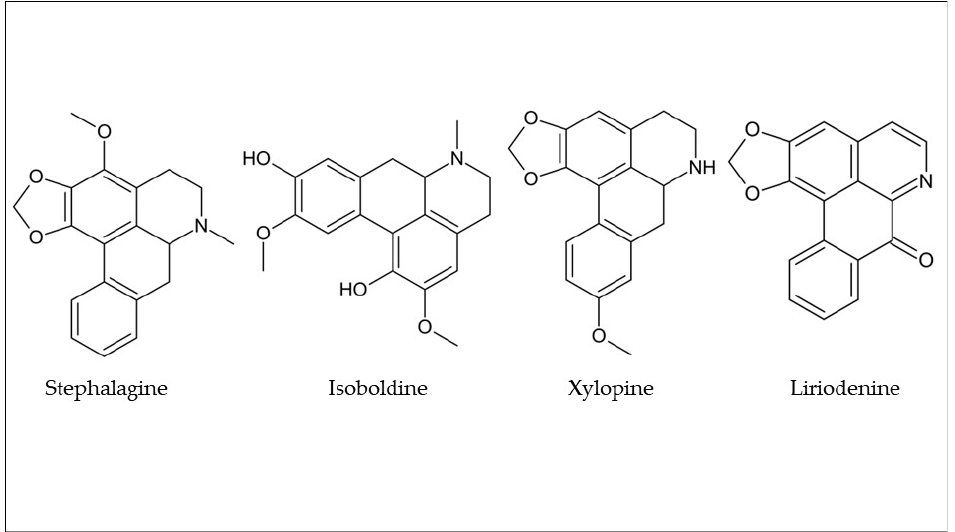
Figure 3. Chemical structures of the most common alkaloids found in araticum fruit. Own author- ship created by ChemSketch